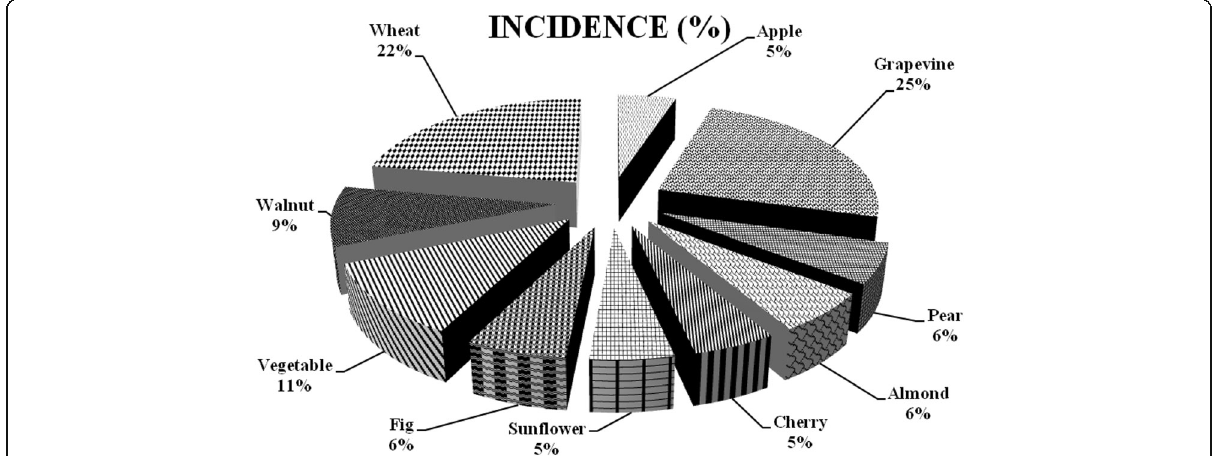
Fig. 1 Occurrence percentage of Pasteuria spp. in different